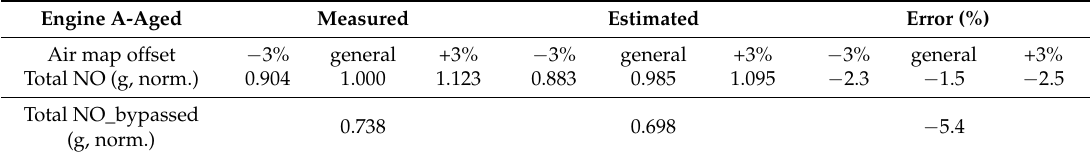
Table 4. Accumulation of the engine-out NO mass results during WLTC when artificial perturbations were applied entire intake air map offset and exhaust gas bypassed prior to the turbocharger. Note that the values were normalized with the measured value of the accumulated NO during nominal operation